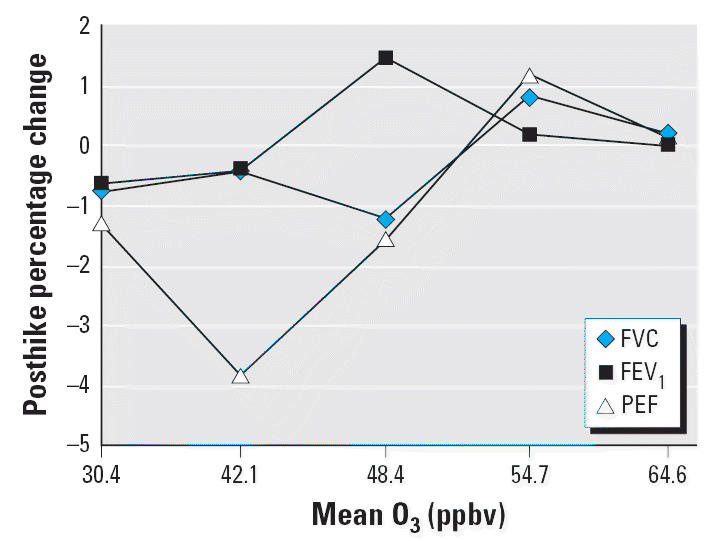
Hikers’ mean posthike percentage change in FVC, FEV1, and PEF as a function of quintile of O3 concentration.